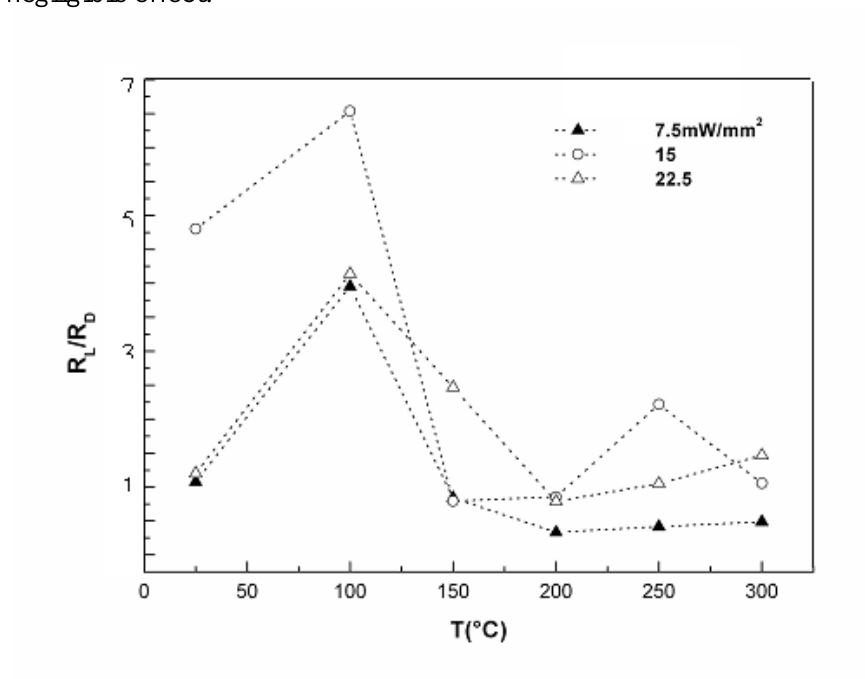
Figure 8. Ratio between the response ( ∆ G/G) toward 100 ppm of CO with light activation (R dark conditions (R ) as a function of the operating temperature and with different UV incident D